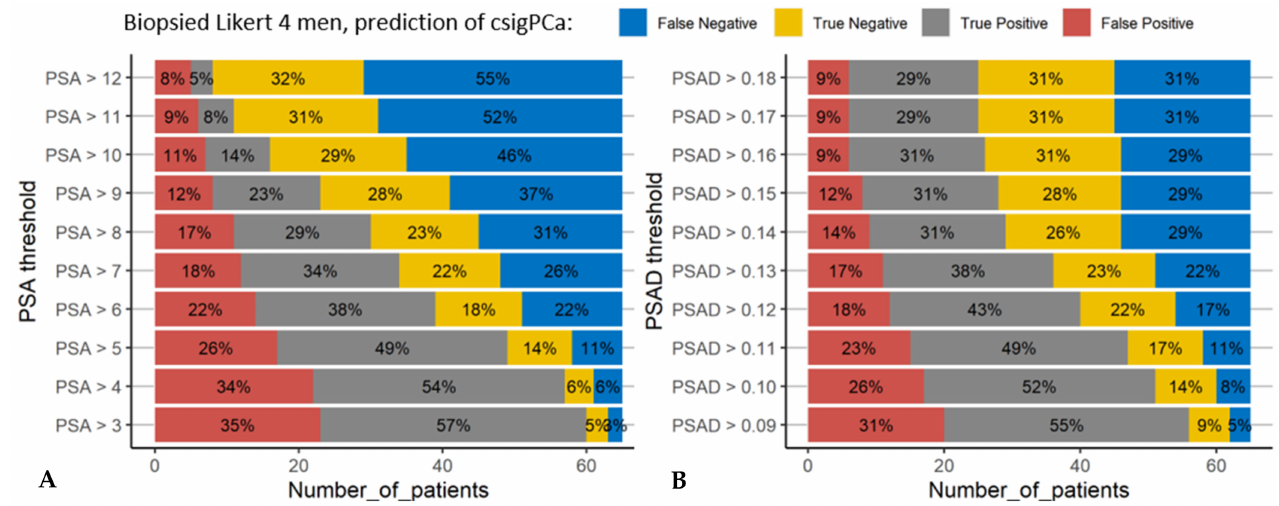
Figure 2. Utility of PSA and PSAD thresholds in patients scored as Likert 4. A range of thresholds of PSA ( A ) or PSAD ( B ) were used to predict the presence of clinically significant prostate cancer on biopsy (Negative = no csigPCa, Positive = yes csigPCa). Each bar represents how accurate each threshold would be if used as a clinical test to predict for csigPCa on biopsy: e.g., for the highest PSAD threshold 0.18 (top bar graph B): if a patients PSAD was <0.18 they would be ‘negative’ on the test and they would have around a 1 in 2 chance of cancer (as True Negative and False Negative are 31% and 31%), if their PSAD was >0.18 they would be ‘positive’ on the test and they would have around a 3 in 4 chance of cancer (as False Positive and True Positive are 9% and 29% respectively). In this context we potentially selecting men for biopsy so would need a very low false negative, e.g., if we use the lowest PSAD threshold of 0.09 we get a 5% false negative rate and the highest true positive rate (55%) but 86% of all men tested would get a positive test result (False Positive plus True Positive) limiting the utility of the test. This data is for Likert 4 men